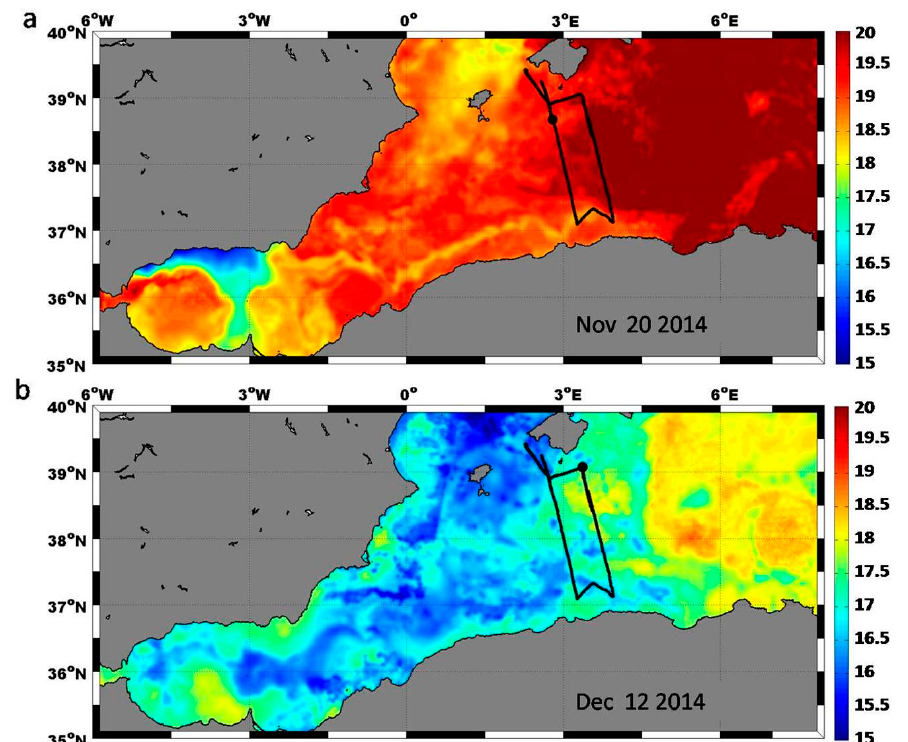
Figure 9. Ultra-high-resolution SST maps of the Alboran Sea and the Algerian Basin on ( a ) 20 November 2014 and ( b ) 12 December 2014. Glider track in black. Large black dots represent glider location on each date. SST in °C.